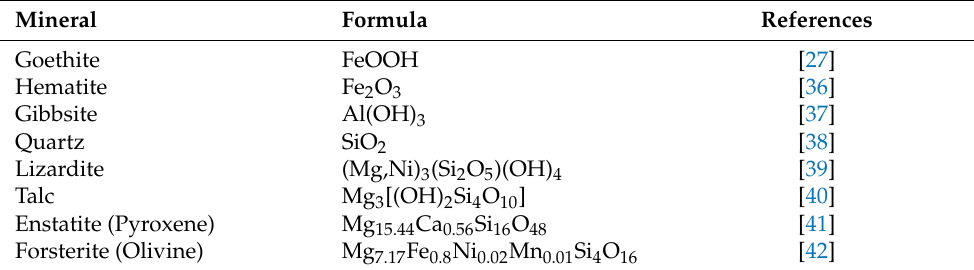
Table 2. Identified minerals in the nickel laterite samples.